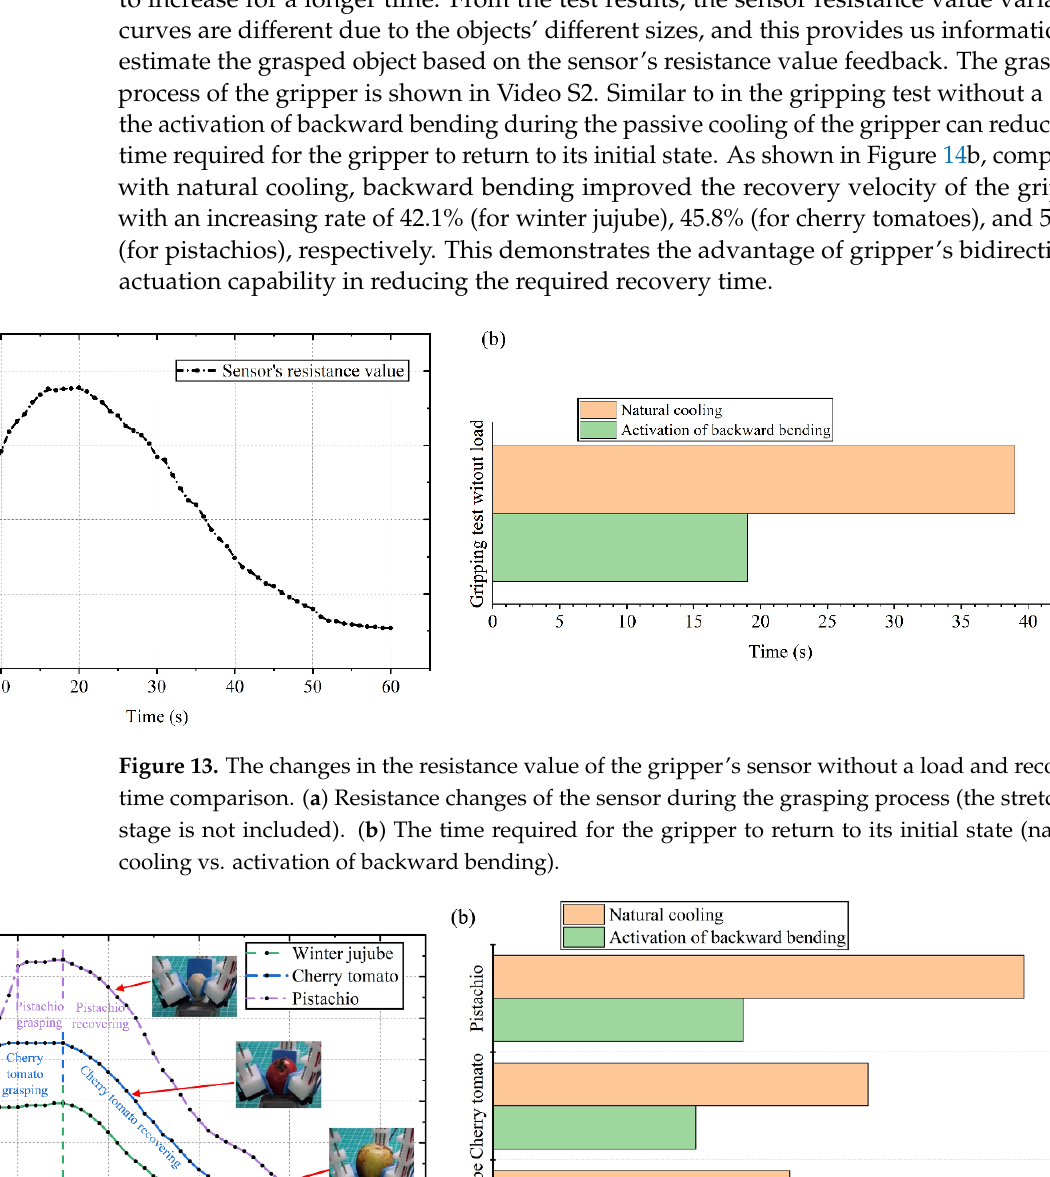
Figure 14. Resistance curves of the sensor based on different objects and their recovery time comparisons. ( a ) Changes in the resistance value during the gripping of pistachios, cherry tomatoes, and winter jujube, respectively. ( b ) The time required for the gripper to return to its initial state (natural cooling vs. activation of backward bending).